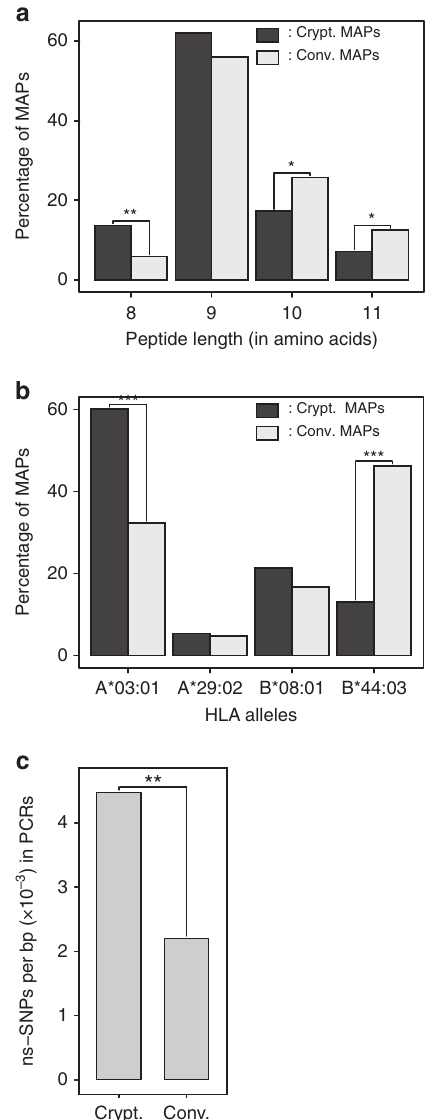
Figure 6 | Crypt. and Conv. MAPs display different features. ( a – c ) Bar plots showing that Crypt. and Conv. MAPs from subject 1 have different ( a ) length distribution, ( b ) allotype distribution and that ( c ) their PCRs exhibit different ns-SNP frequencies (from dbSNP138). In all cases, statistical significance was assessed using a two-sided Fisher’s exact test: